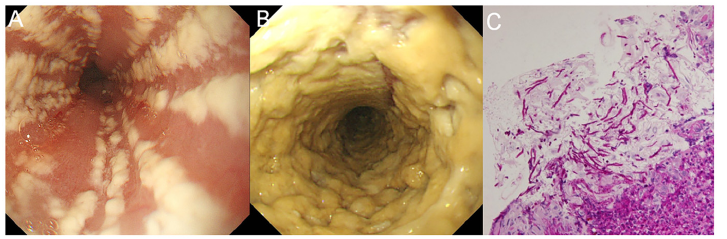
Fig 1. Endoscopic findings (A, B) and pathological findings (C) of candida esophagitis. (A) Confluent, linear, and nodular elevated plaques. (B) Thick white plaque cover on esophageal mucosa circumferential narrowing the lumen. (C). Numerous Candida pseudohyphae and spores in the exfoliated esophageal epithelium and detached superficial squamous epithelium (×400).